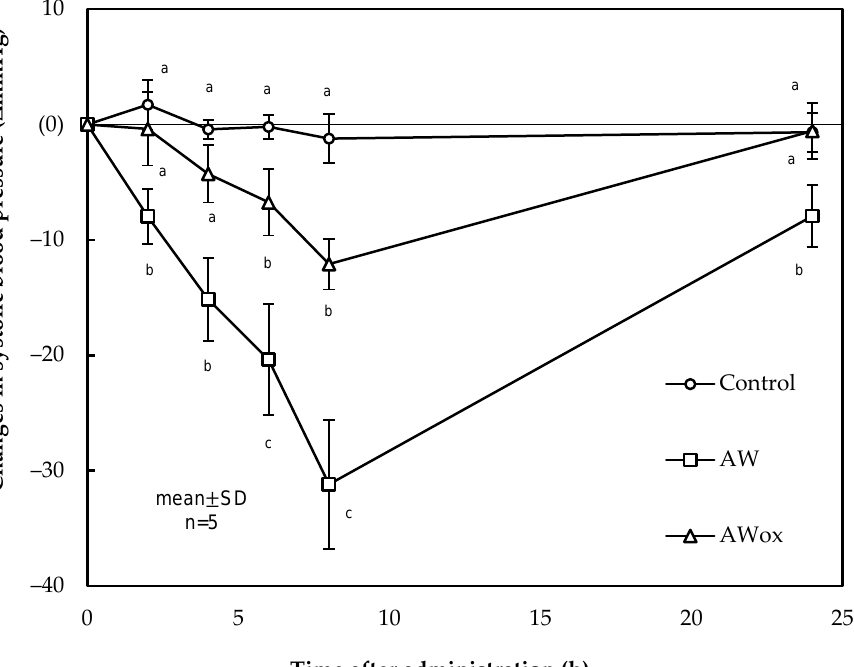
Figure 2. Systolic blood pressure drop with the treatment of a single oral administration of the dipeptide AW and AWox. Each point indicates the mean of systolic blood pressure of n = 5 SHR. Treatments were control (distilled water) and dipeptides AW and AWox. Different letters indicate significant difference from control at each time ( p < 0.05). Reproduced from [85] with permission.